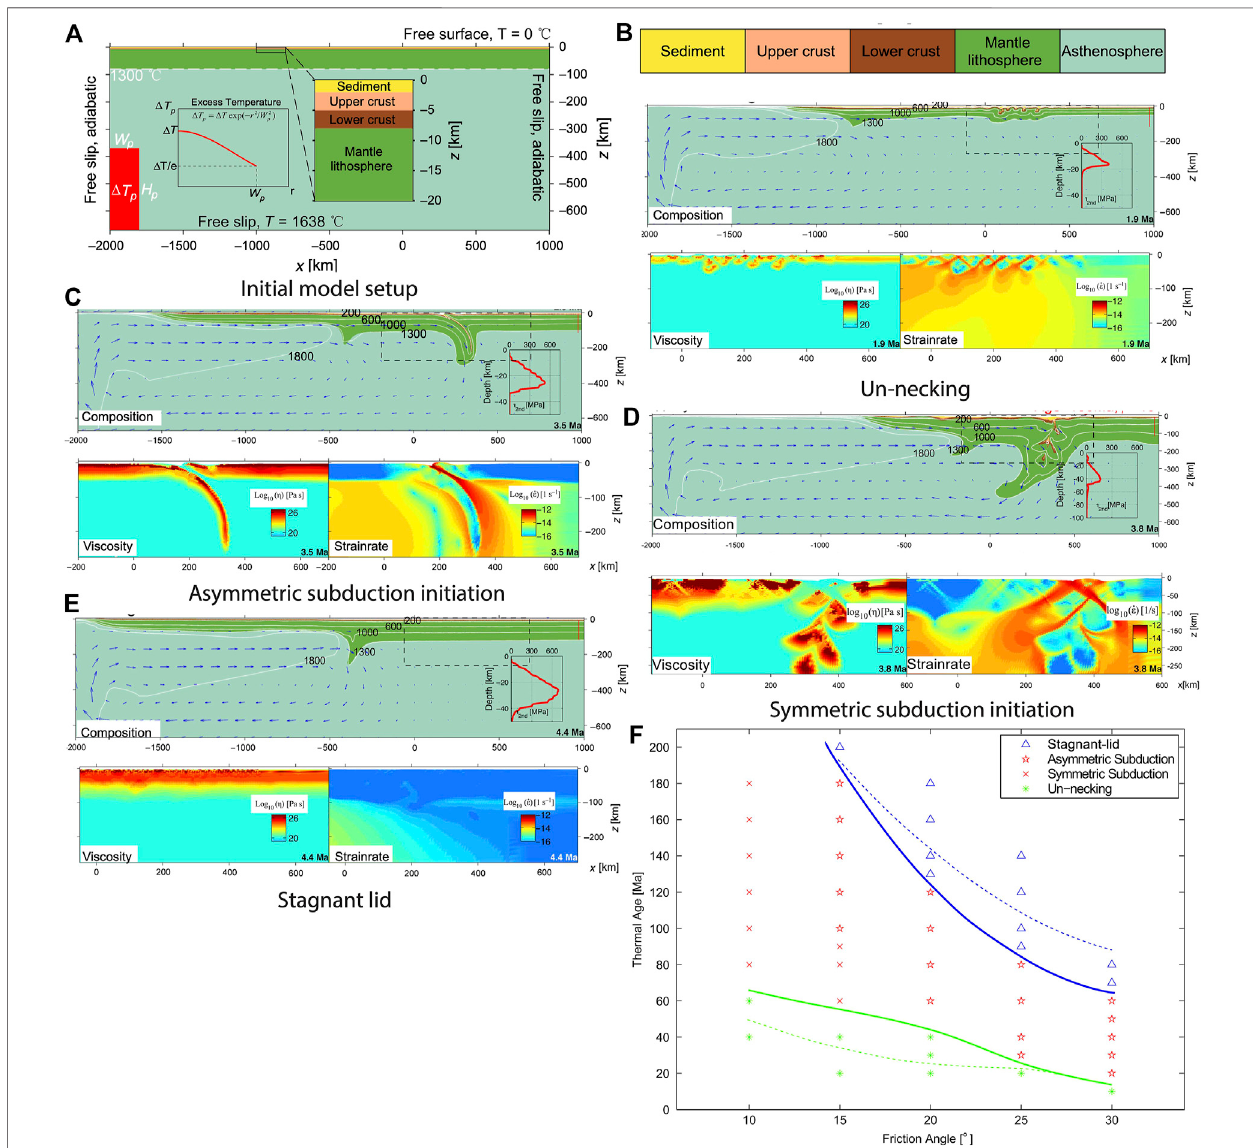
FIGURE 4 | Modeling results of Lu et al., 2015. (A) Initial model setup and (B – E) four different regimes resulting from the modeling experiments: (B) un-necking, (C) asymmetric subduction initiation, (D) symmetric subduction initiation, and (E) stagnant lid. In (A – E) the upper panels show the compositional fi eld and the lower panels illustrate viscosity and strain rate. (F) Summary of modeling experiments (modi fi ed from Lu et al., 2015).